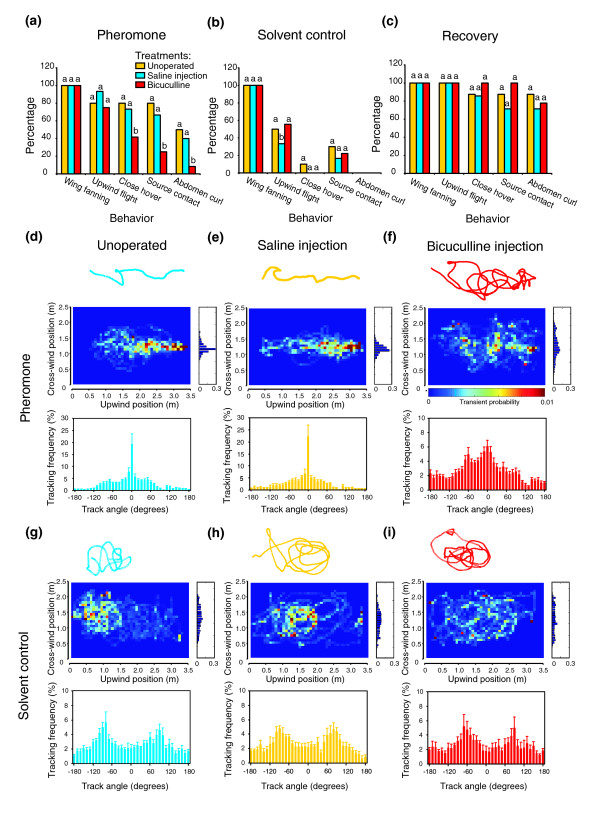
Bicuculline significantly affects pheromone-mediated navigation behavior. (a-c) Behavioral measurements on unoperated (gold), saline-injected (cyan) and bicuculline-injected (red) moths in a wind tunnel supplied with (a) pheromone or (b) solvent control (cyclohexane). Neither bicuculline nor saline injection affected a moth's ability to be motivated to fly (wing-fanning) or make upwind progress. A significantly lower percentage of bicuculline-injected moths (n = 12) displayed close hover, source contact and abdomen curl, compared with the unoperated (n = 10) and saline-injected (n = 15) groups (G test: p < 0.05). Under cyclohexane, all moths showed wing-fanning behavior, but only 30–50% of moths in each group (n = 10, 6, 9 for unoperated, saline-injected and bicuculline-injected, respectively) progressed upwind and an even lower percentage displayed close hover and source contact. None of the animals that came close to the source displayed abdomen curl. (c) The effects of bicuculline on close hover, source contact and abdomen curl shown in (a) were reversed after recovery for at least 2 h in a dark environmental chamber (n = 8, 7, 9 for unoperated, saline-injected and bicuculline-injected, respectively). Different letters within a behavioral category denote statistical significance (G test:
p <0.05). (d-i) Flight-track analysis on unoperated (d, g), saline-injected (e, h) and bicuculline-injected (f, i) moths with pheromone or solvent control in the wind tunnel. (d, e) Using pheromone as the odor source, the unoperated and saline-injected moths flew directly toward the odor source, thus resulting in approximately straight flight tracks (top), centrally distributed transit probability (middle panels) and track-angle distribution histograms (bottom panels) with a prominent peak at zero degrees (mean ± SEM). The central distribution of transit probability is further demonstrated with a summed bar graph (along the wind direction) located to the right of the pseudocolor plots, showing a single peak at the center. (f) Bicuculline-injected moths, on the other hand, markedly diminished the central peak as well as the tracking frequency peak at zero degree track angle. (g-i) Replacing the pheromone with solvent control (cyclohexane) in the wind tunnel resulted in unanimous 'looping' flight tracks in all three treatment groups, reflecting an engagement of cross-wind casting in these moths, which is also shown in the randomly distributed transit probability of occupancy as well as in the bimodal distribution of track angle histograms.